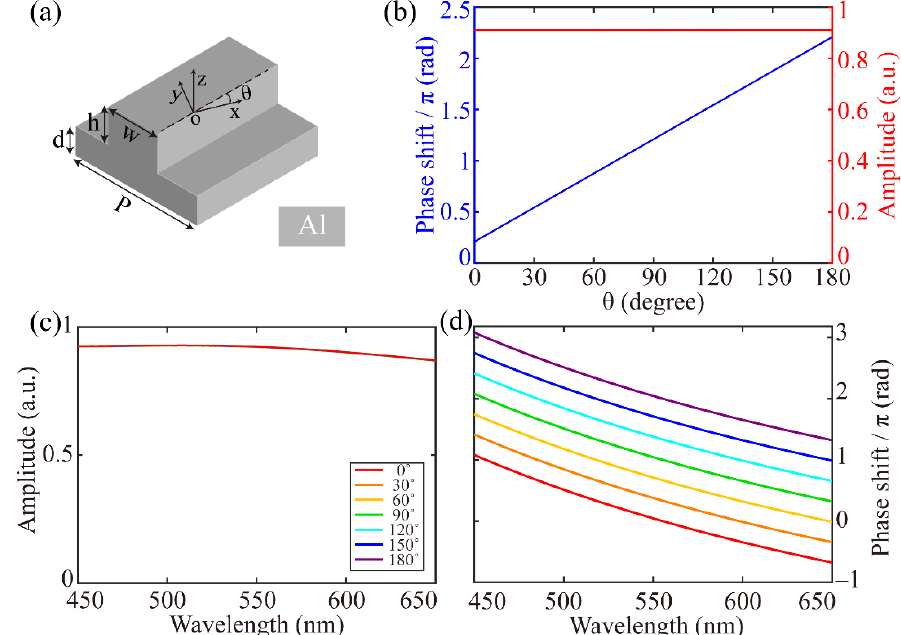
Figure 1. ( a ) Simplified model of a catenary-shaped nanostructure. ( b ) Simulated phase (blue line) and amplitude (red line) profiles of reflective cross-polarization light at the wavelength of 532 nm. Simulated amplitude ( c ) and phase ( d ) profiles for different wavelengths and rotation angles.